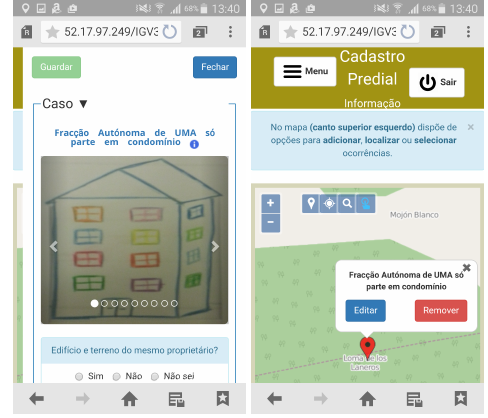
Figure 6: HTML5 in Action - Mobile Usage - No/few CSS mod- ification required